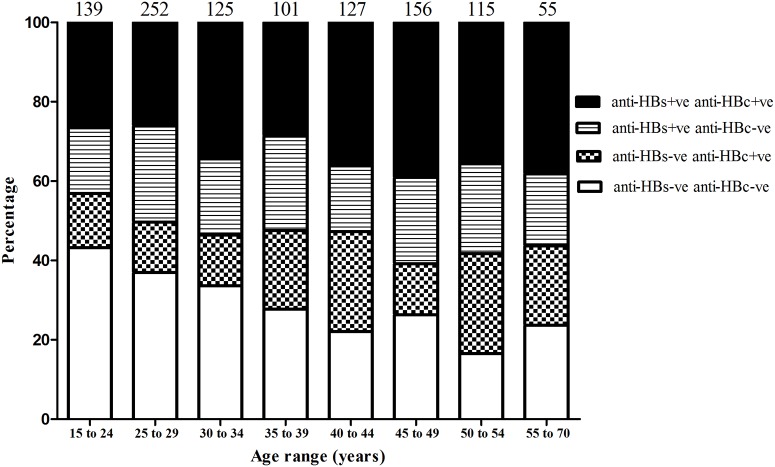
Hepatitis B seroprofile with age.Excluding 3 participants with no age data and 50 with equivocal anti-HBs data. Numbers above columns represent number per age group.